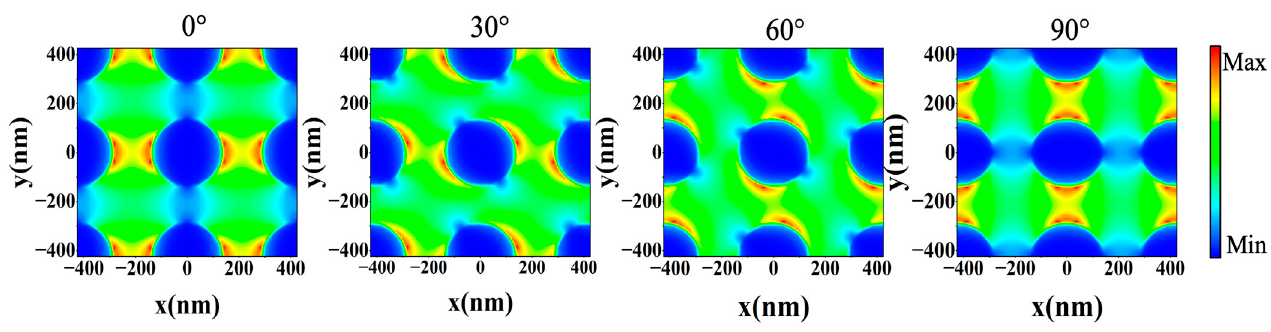
Figure 8. Absorptance spectra of the present absorbers with different angles of polarization at normal incidence.